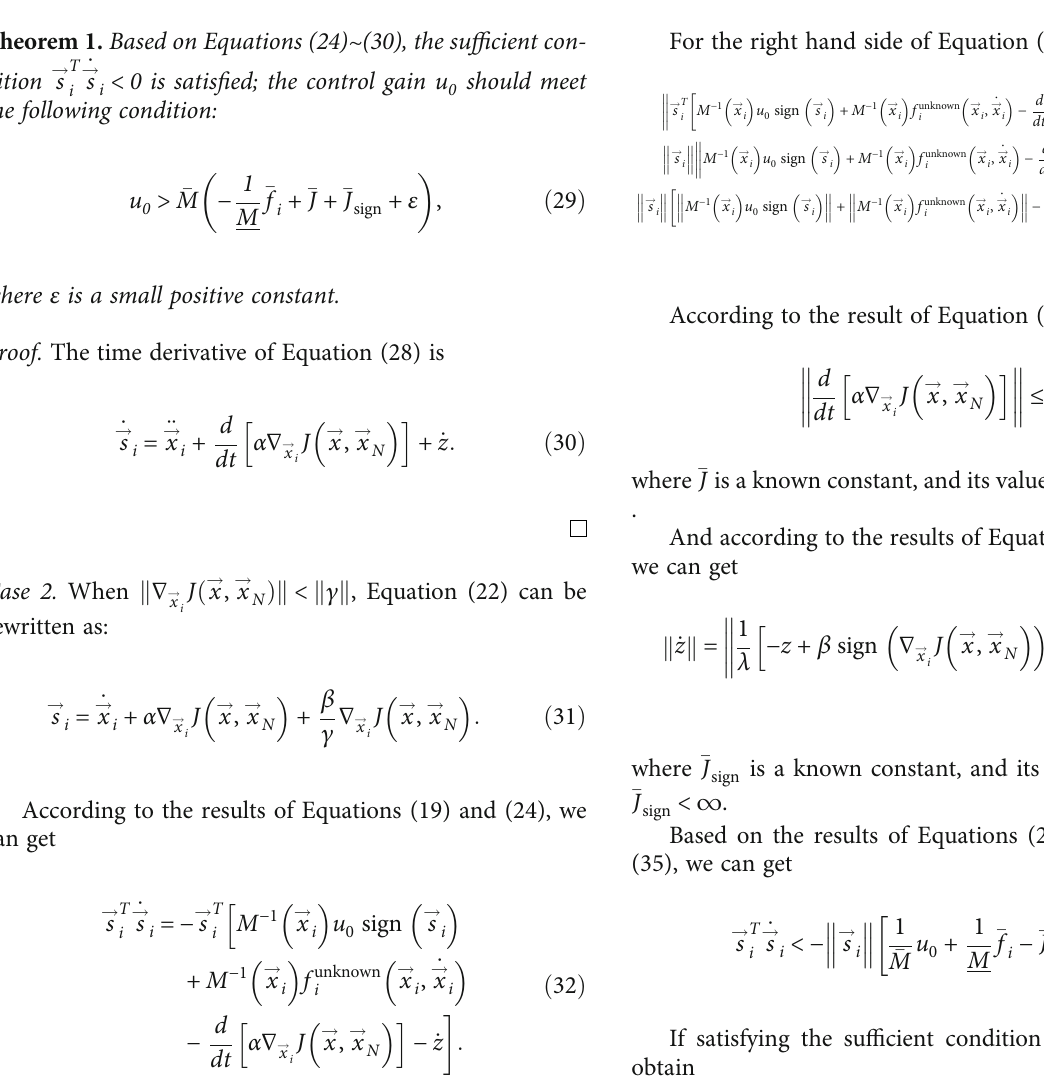
Figure 1: The tracking trajectories of the traditional